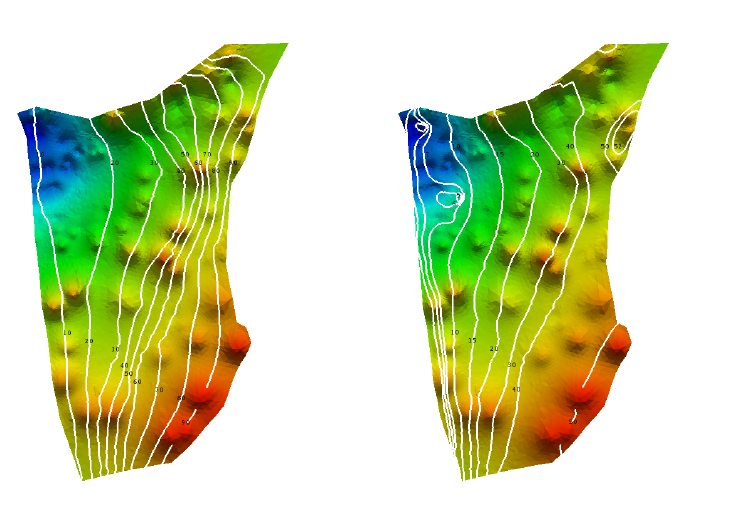
Figure 12. Contours representing the freshwater potential of the Souss–Chtouka Plain illustrated on the bottom of the aquifer in 1968 ( left ) and 2048 ( right ).